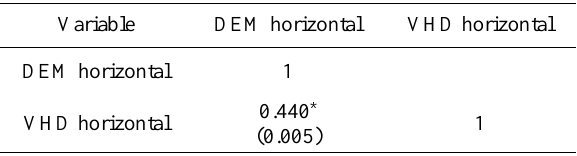
Correlation between DEM and VHD in the horizontal